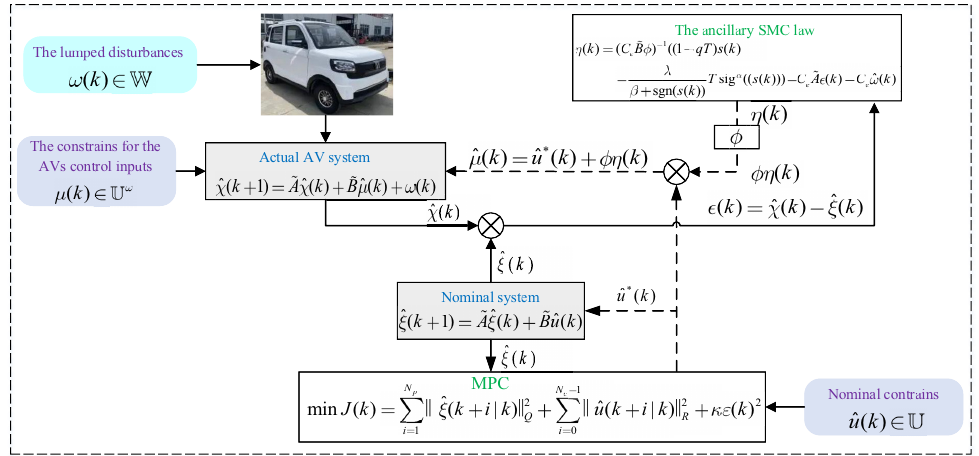
Figure 2. The proposed robust SMC-based tube MPC